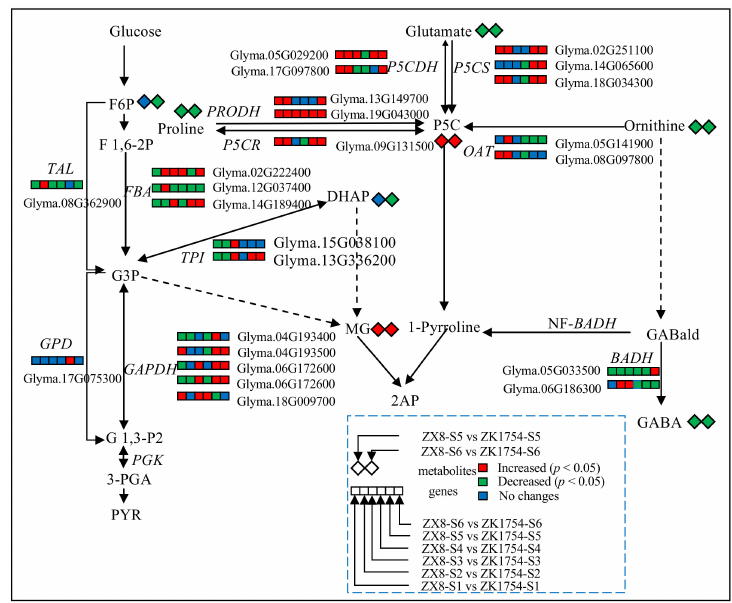
Figure 3. Specific synthesis pathway of 2AP in soybean. Genes or enzymes and substrates or prod- ucts are shown in italics and normal, respectively. TAL: Transaldolase; FBA: Fructose-bisphosphate al- dolase; TPI: Triosephosphate isomerase; P5CR: Pyrroline-5-carboxylate reductase; GPD: Glyceraldehyde-3- phosphate dehydrogenase NADP + ; GAPDH: Glyceraldehyde-3-phosphate dehydrogenase; PRODH: Pro- line dehydrogenase; P5CDH: 1-Pyrroline-5-carboxylate dehydrogenase; P5CS: ∆ 1